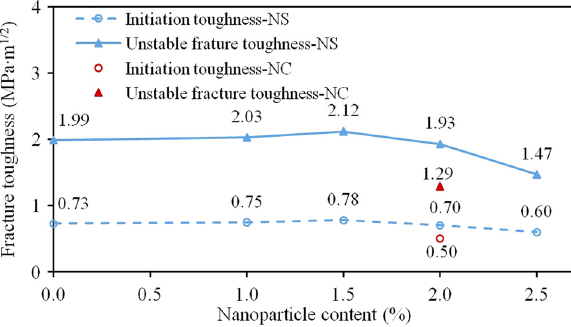
Figure 8: E ff ects of nanoparticle content and type on fracture toughness.